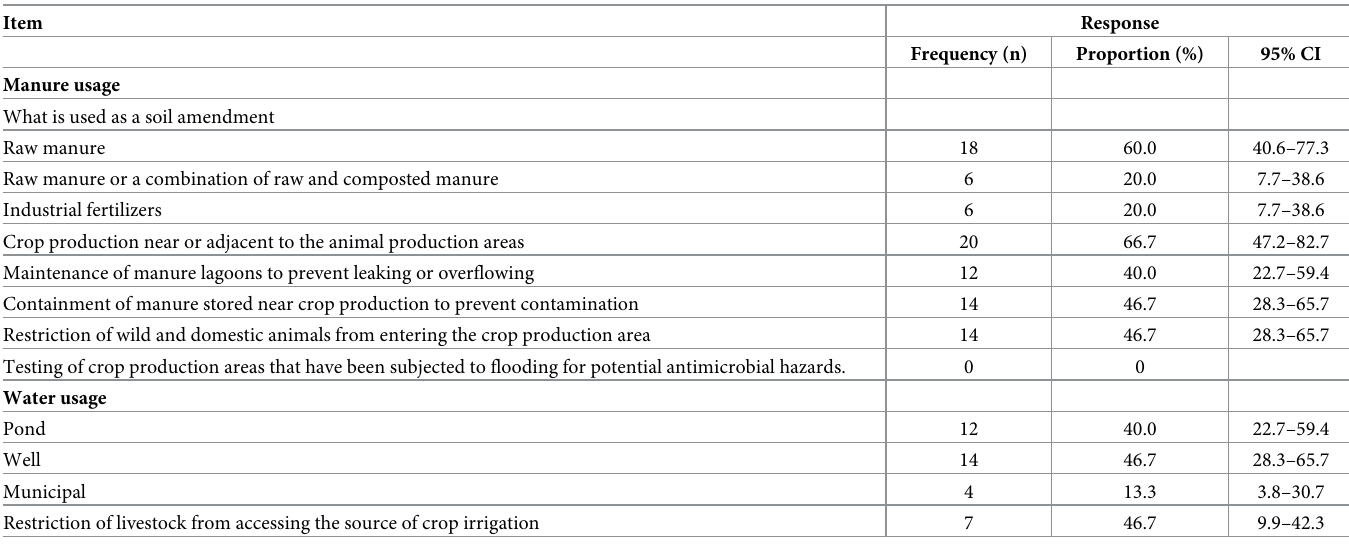
Table 7. Manure and water usage in Chinese cabbage production (n =